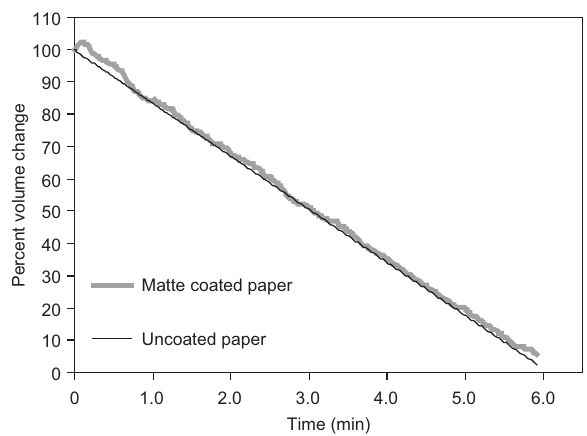
Figure 4 Volume changes of a water drop on uncoated and coated paper surfaces over